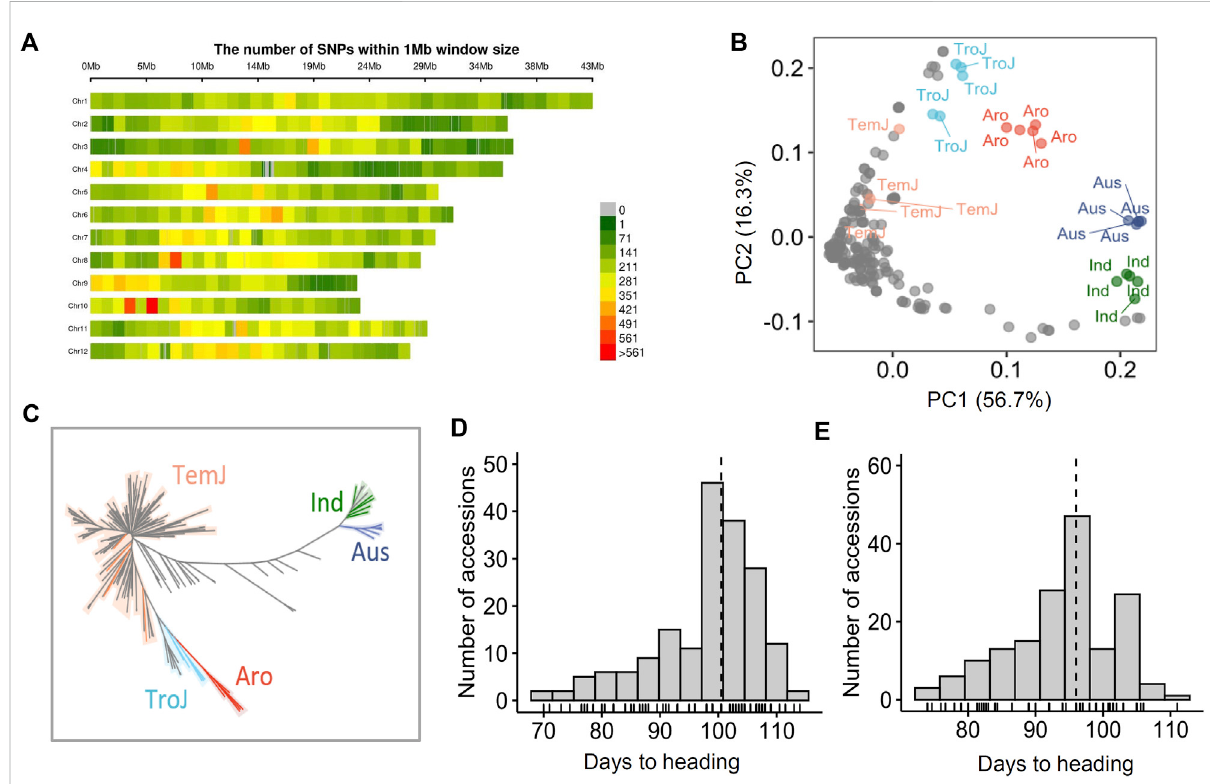
FIGURE 1 Population structure and phenotypic variation in North Korean rice accessions. (A) Chromosome-wise SNP density plot representing the number of SNPs within a 1 Mb window size. (B) PCA based on 215 varieties (190 NK and 3K-RGP derived 25 rice accessions). The two top principal components (PC1 and PC2) explained 73% of the genetic variation. Accessions are color-coded: orange, TemJ ; light blue, TroJ ; red, Aro ; dark blue, Aus ; green, Ind (C) Neighbor-joining tree. (D and E) Histograms showing phenotype distribution of heading date in 2018 (D) and 2019 (E)